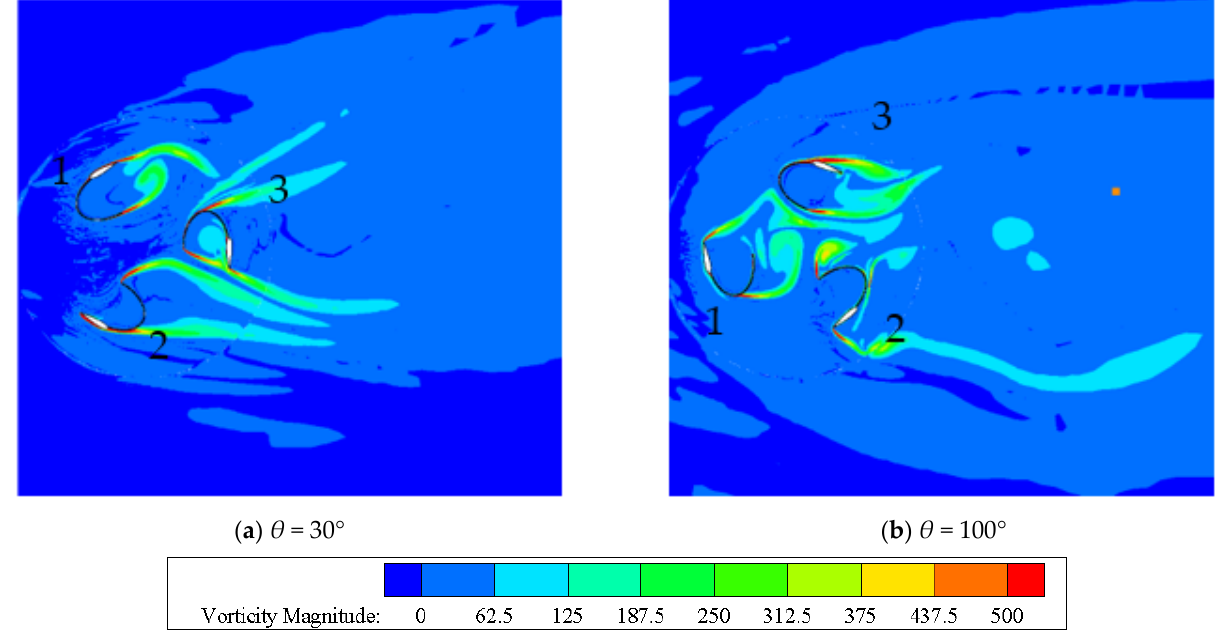
Figure 15. Vorticity magnitude of 3-bladed LDCS ( U = 6 m/s): ( a ) θ = 30°; ( b ) θ = 100°.